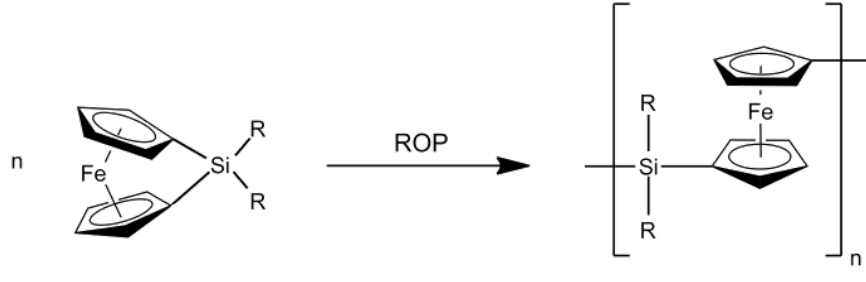
Figure 4. Ring opening polymerization (ROP) of ansa -silaferrocenophanes yielding poly(ferrocenylsilane) (R =